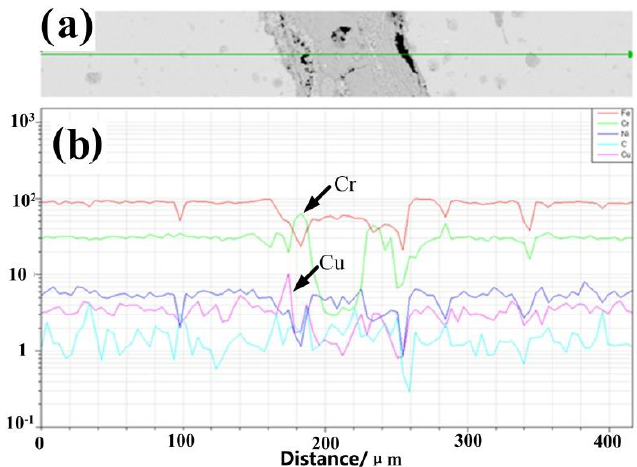
Figure 7. SEM-EDS elemental line-scan map during hot deformation with the strain of 0.5 at 1050 °C. ( a ) line-scan map, ( b ) line-scan EDS.